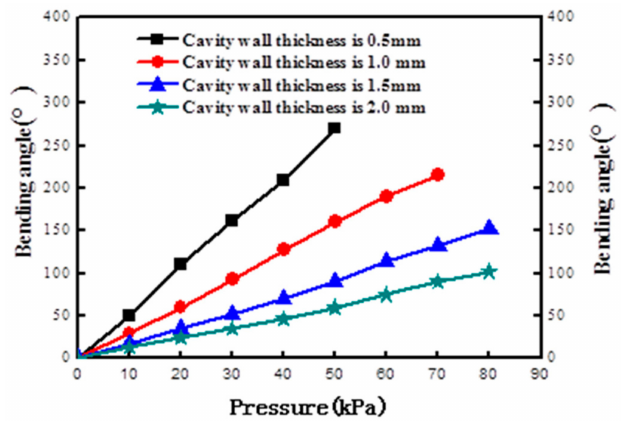
Figure 7. Effect of cavity wall thickness on bending angle.